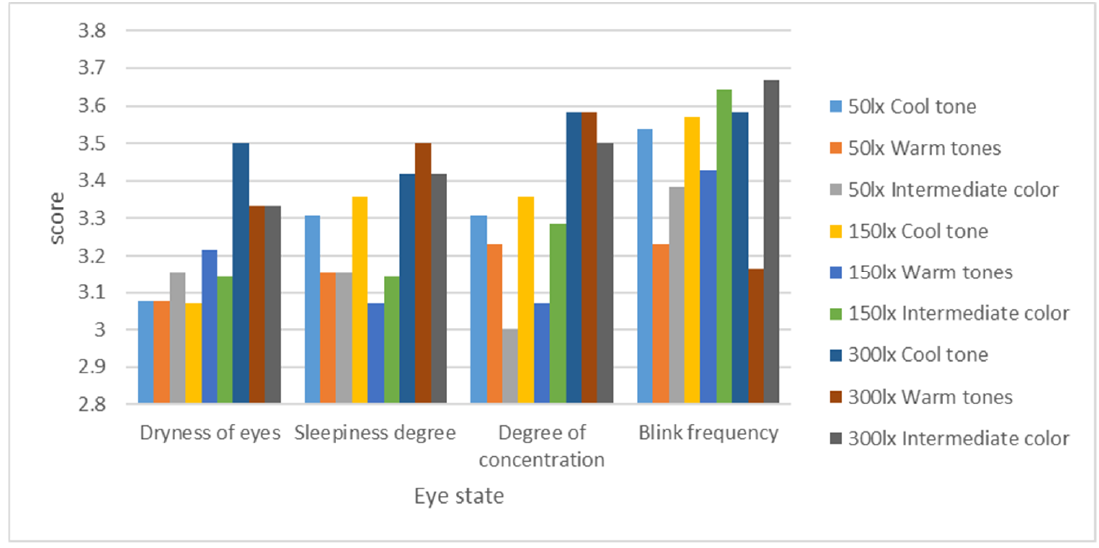
Figure 6. Subjective questionnaire survey of visual fatigue.